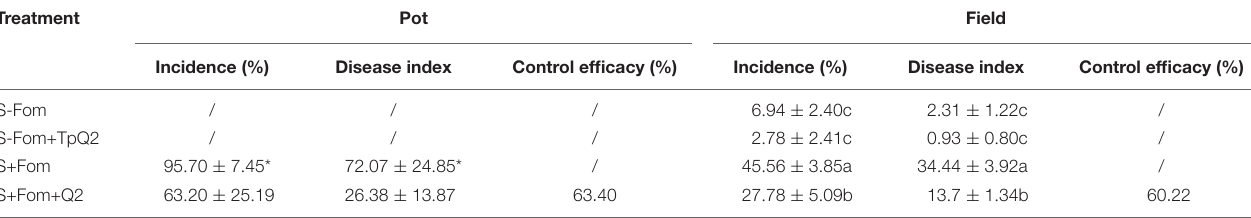
TABLE 1 | Biocontrol efficacy of TpQ2 on bitter gourd Fusarium wilt disease during pot and field trials. Treatment Pot Field Incidence (%) Disease index